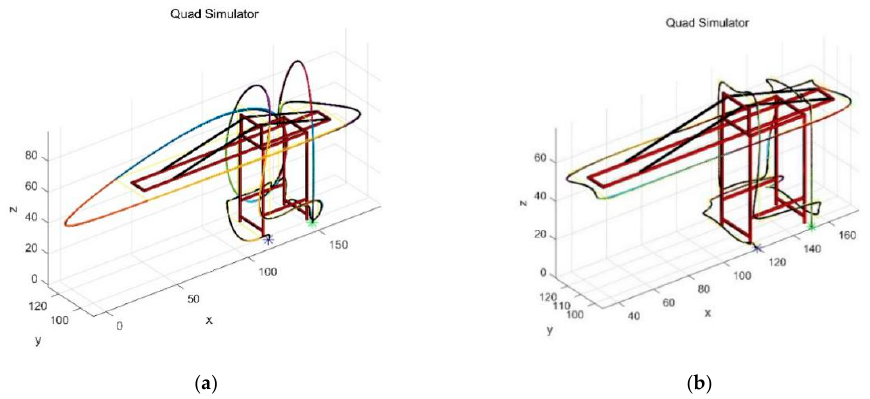
Figure 7. Comparison of trajectory optimization simulation results: ( a ) the trajectory generated by the unconstrained quadratic programming (UQP) method; ( b ) the trajectory generated by the proposed method. Table 4. Comparison of quantitative analysis results of the two methods.